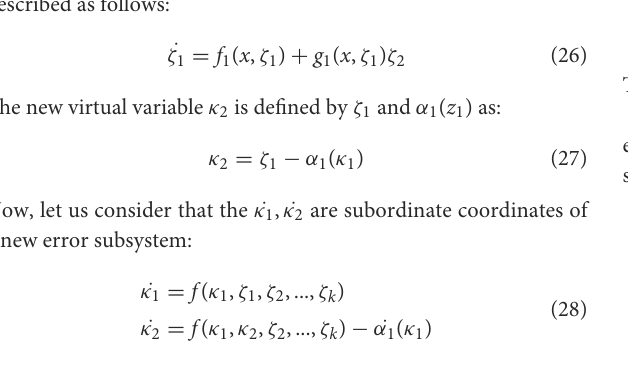
1 > 0. The dynamic change of V 1 is T = < 0 in R n V 1 Q κ T 1 ˙ = −